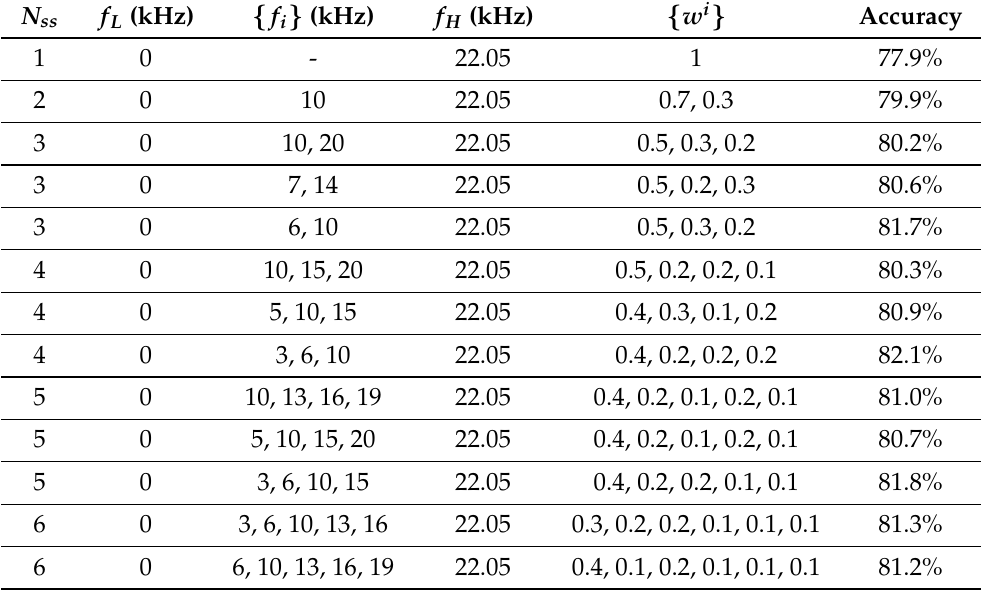
Table 9. Classification accuracy under different N ss , { f i } , and { ω i } .